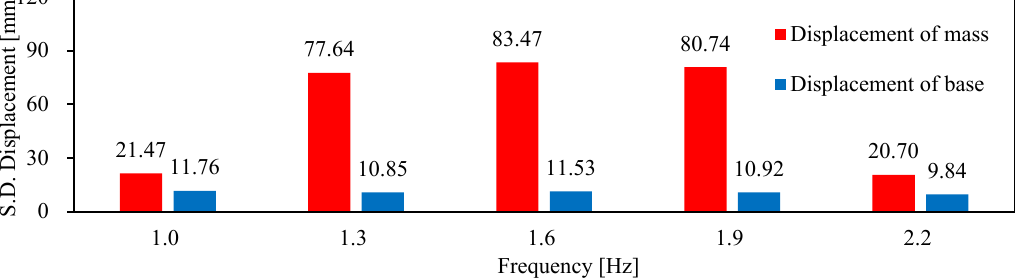
Figure 23. Comparison of S.D. displacements of random and period excitation.